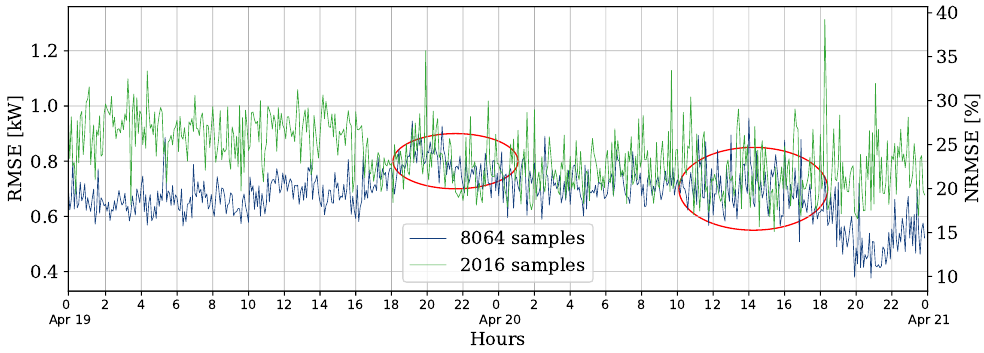
( a ) Root mean squared error (RMSE) for the power generation model using fixed window sizes